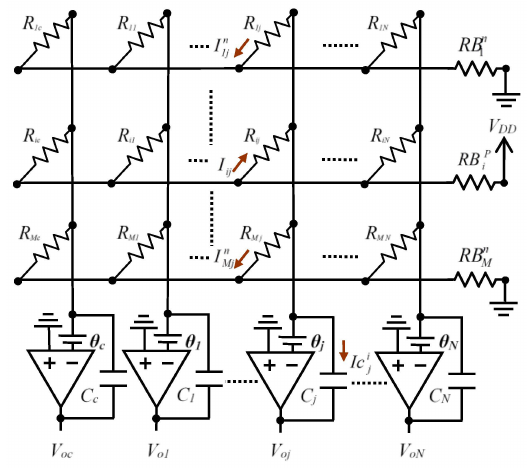
Figure 5. Equivalent circuit for the activation of a single